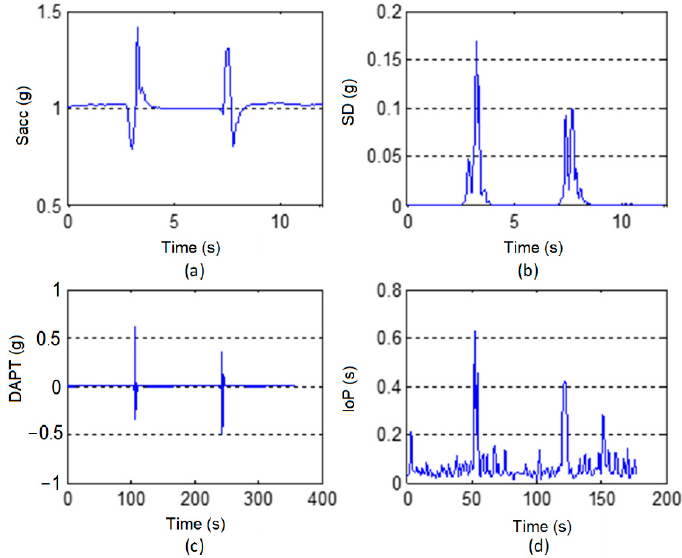
Figure 13. Diagram of features in D08: ( a ) Sacc over time; ( b ) SD over time; ( c ) DAPT over time; ( d ) IoP over time.